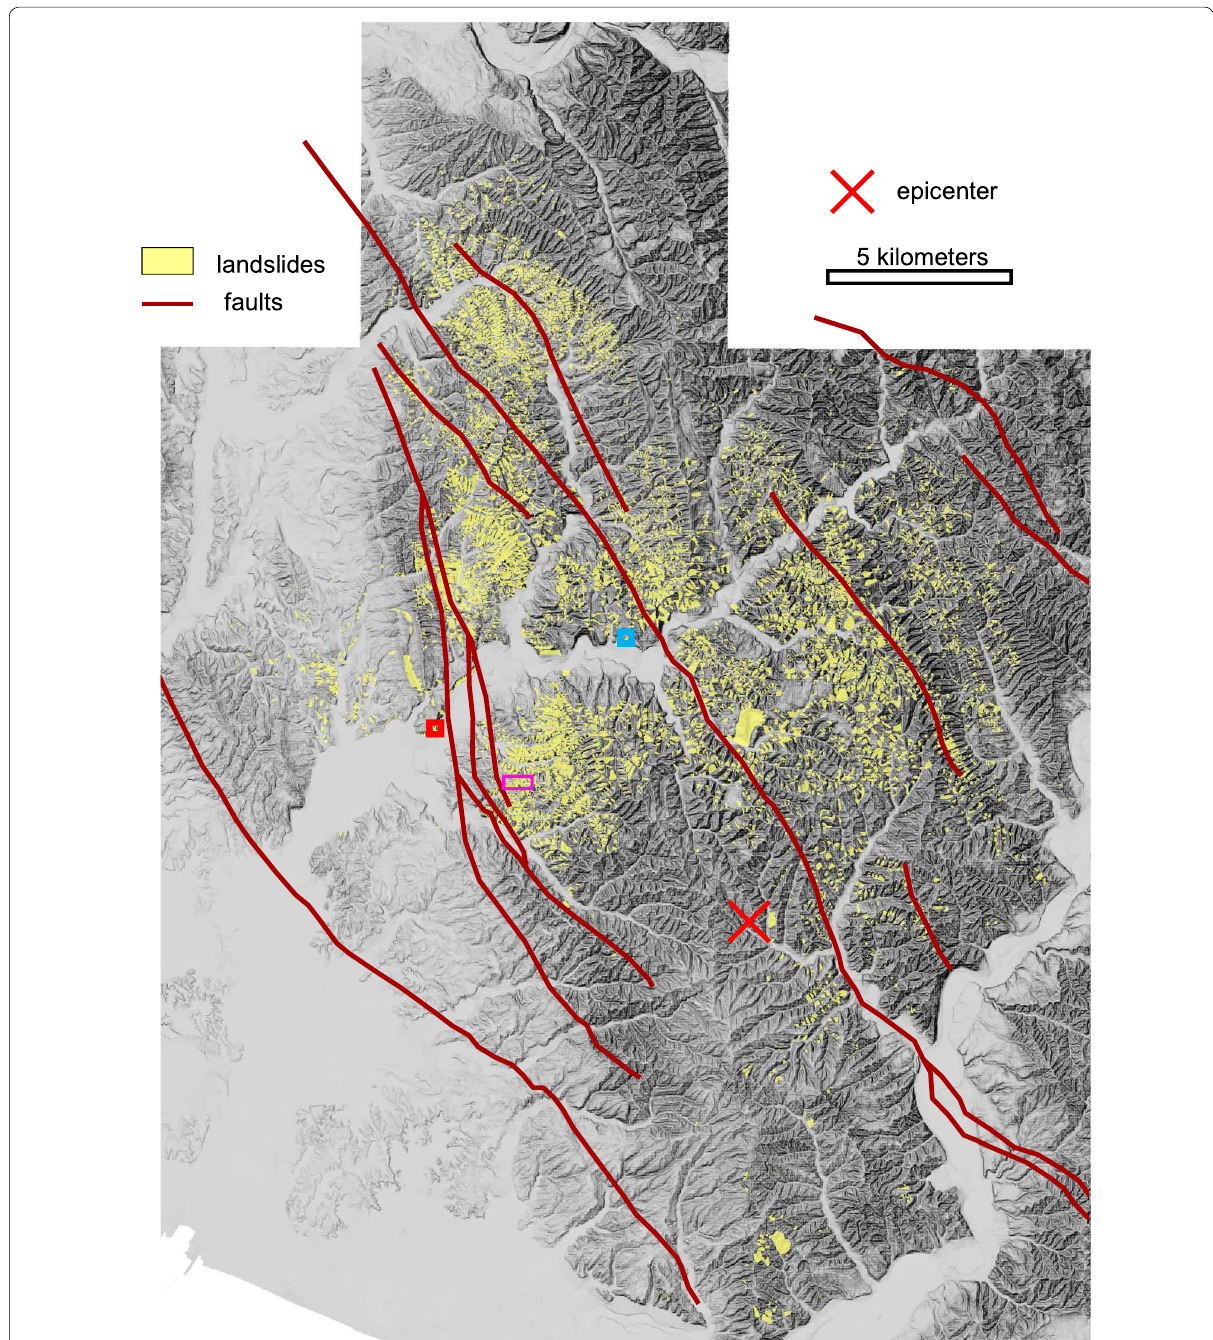
Fig. 3 Distribution of landslides induced by the Hokkaido Eastern Iburi Earthquake in 2018. Fault locations are based on a 1:200,000 land geological map of the Ishikari Depression and its surrounding area, provided by Ozaki et al. (2014). Landslides were identified by Kita (2018). Pink square: area shown in Fig. 5; Red square: location of a photographic image presented in Fig. 6; Blue square: location of soil stratification demonstrated in Fig.